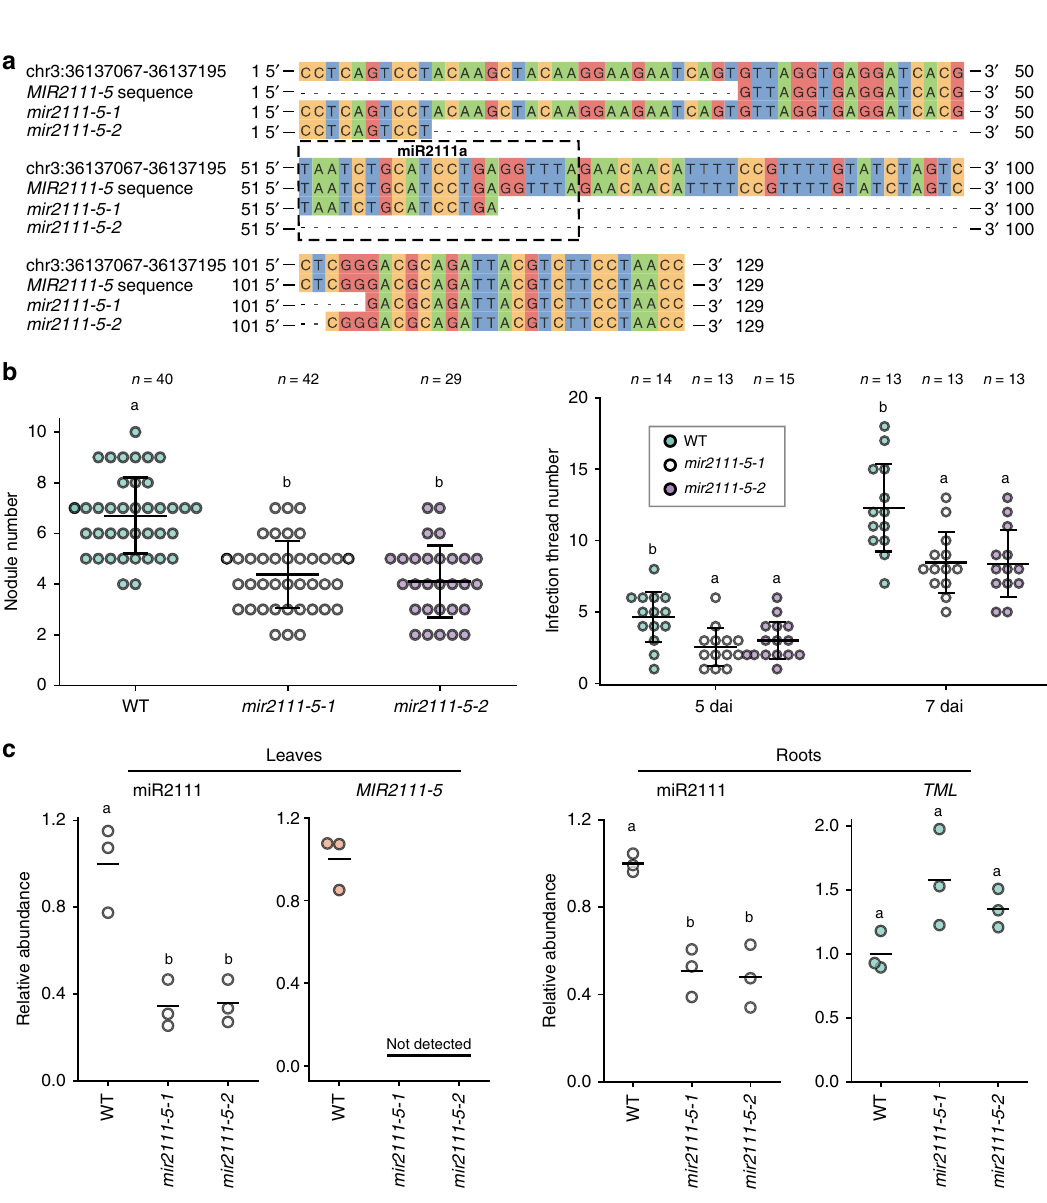
Fig. 5 MIR2111-5 knockout signi fi cantly inhibited nodulation and accumulation of mature miR2111s. a Nucleotide sequences of MIR2111-5 and its knockout lines. b The numbers of nodules (21 days after inoculation) and infection threads (5 and 7 days after inoculation) on roots of WT, mir2111-5-1 , and mir2111-5-2 . Bars indicate mean ± standard deviation. c qRT-PCR analyses of mature miR2111s, MIR2111-5 , and TML in leaves and roots at 14 and 7 days after germination, respectively. n = 3 individual biological replicates for each treatment. Bars indicate mean values. b , c Scatterplots show individual biological replicates as dots. Different letters indicate signi fi cant differences ( P < 0.05) from Tukey ’ s honestly signi fi cant difference